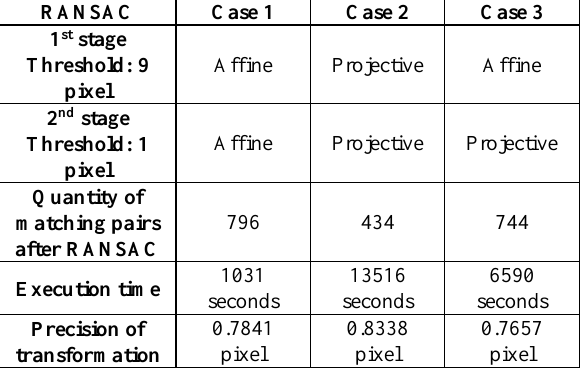
Table 15. Example of matching matrix.